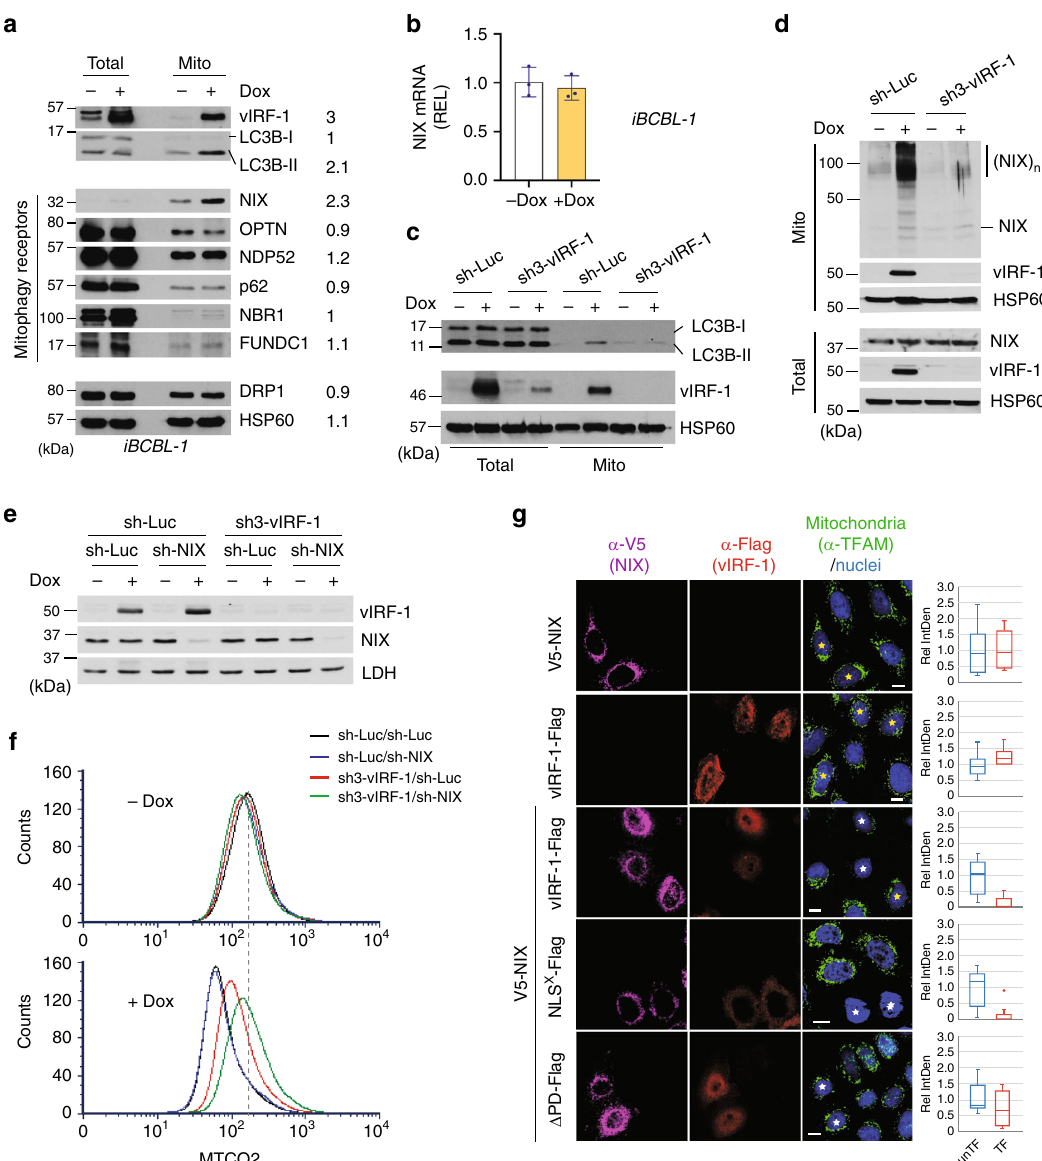
Fig. 3 vIRF-1 activates NIX-mediated mitophagy. a Immunoblots of total-cell and mitochondrial extracts derived from iBCBL-1 cells that were left untreated or treated with Dox for 2 days. The relative band intensities of the Dox-treated mitochondrial fraction to the no Dox control mitochondrial fraction were calculated and are shown in the column (right). Heat shock protein 60 (HSP60) was used as loading control. b RT-qPCR analysis of the mRNA expression of NIX in latent and lytic iBCBL-1 cells. The relative expression levels (REL) were calculated using the comparative Ct method. Mean ± SD, n = 3. c , d Immunoblots of total-cell and mitochondrial extracts derived from control and vIRF-1-depleted iBCBL-1 cells that were left untreated or treated with Dox for 2 days. (NIX) n indicates a putative dimerized or polymerized form of NIX. e Immunoblot validation of Dox-induced depletion of NIX and/or vIRF-1 in the respective shRNA-transduced iBCBL-1 cell lines (see Methods). The cells were left untreated or treated with Dox for 2 days. LDH was used as loading control. f Flow cytometric analysis of MTCO2 expression in latent and lytic iBCBL-1 cells that were depleted of NIX and/or vIRF-1. The cells were left untreated or treated with Dox for 4 days. The dotted line shows the peak for MTCO2 in latent cells (no Dox) doubly transduced with sh-Luc. g IFA analysis of mitochondria content (TFAM) in HeLa.Kyoto cells that were transiently transfected for 24 h with V5-NIX and/or Flag-vIRF-1 (wild type and its derivatives, NLS X and Δ PD). Singly and dually transfected cells are marked with yellow and white stars, respectively. TFAM immuno fl uorescence intensity was measured using ImageJ software; background-corrected integrated density (IntDen) was measured in randomly selected cells ( n = 20, untransfected (unTF) or transfected (TF) cells) from at least four to fi ve microscope images. Relative IntDen was calculated by dividing by unTF control, and the distribution of data is shown in the boxplots that display the full range of variation (whiskers), the likely range of variation (box), the median (center line), and the outlier (dot). Scale bar, 10 µ m. Source data are provided as a Source Data fi